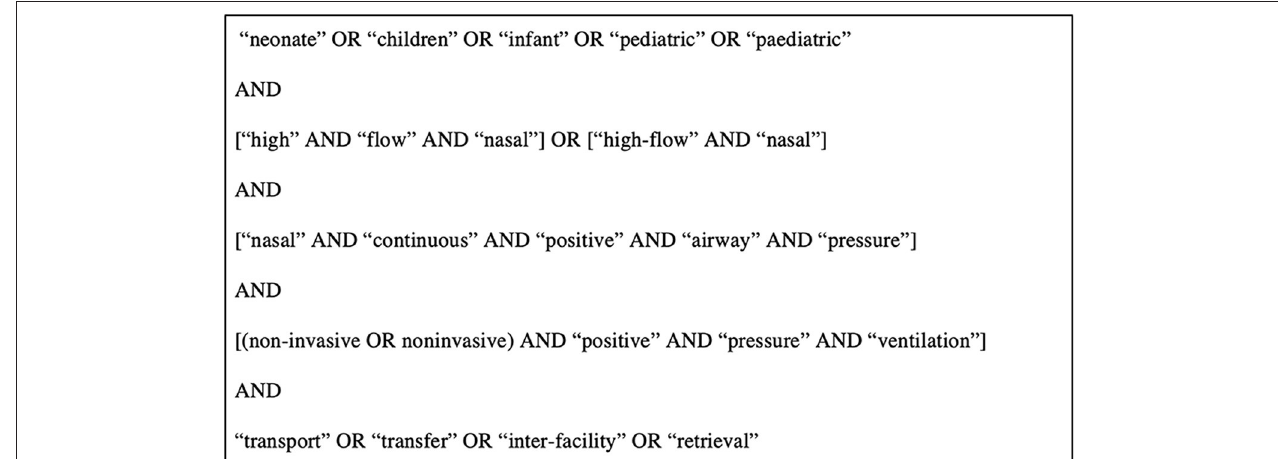
FIGURE 1 | Search query.